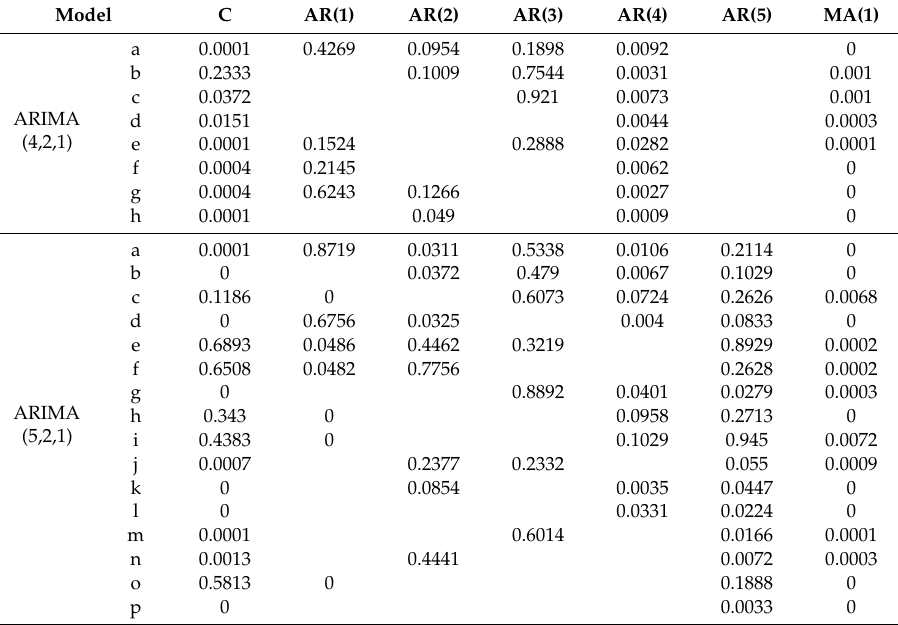
Table 4. Results of the model parameter significance τ statistic test (P-value).